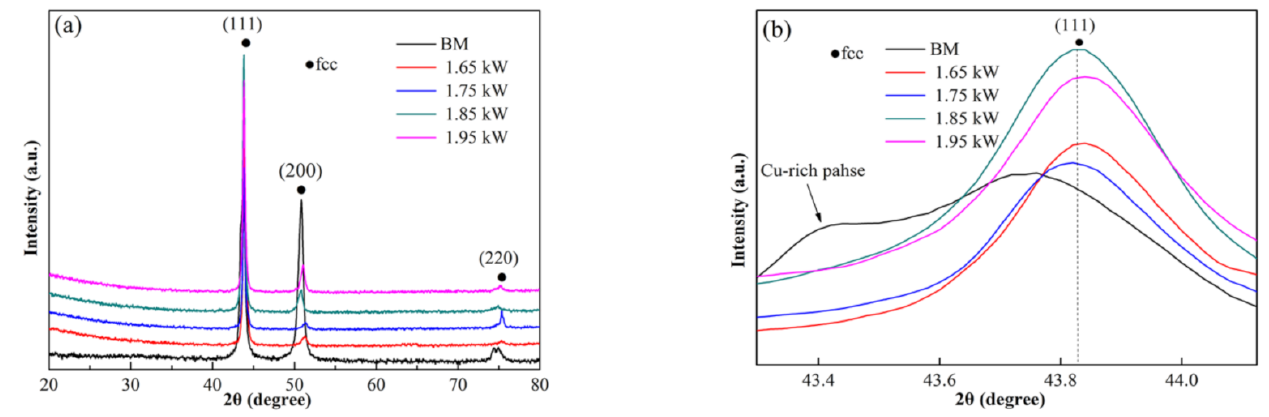
Figure 4. XRD patterns of the FZ at different laser powers: ( a ) XRD patterns and ( b ) detailed scans for the (111)